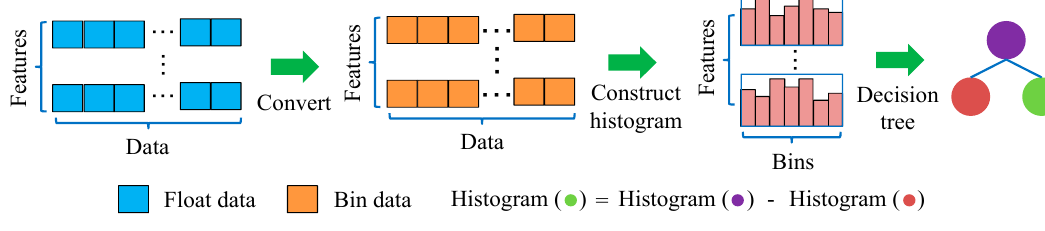
Figure 4. Histogram-based decision tree algorithm.